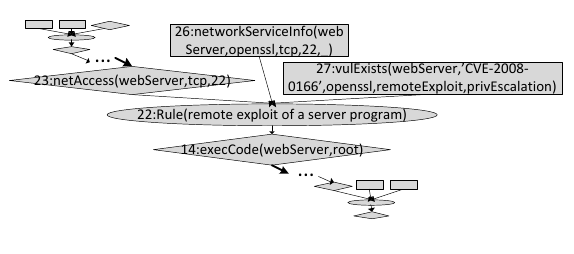
Figure 2. A Portion of an Example Logical Attack